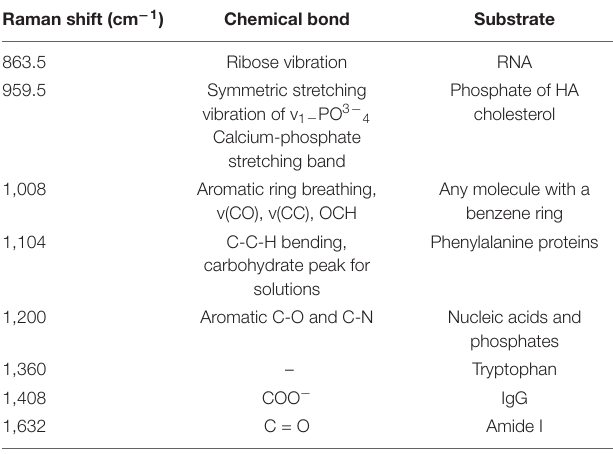
TABLE 2 | Main bands observed and corresponding assignment of